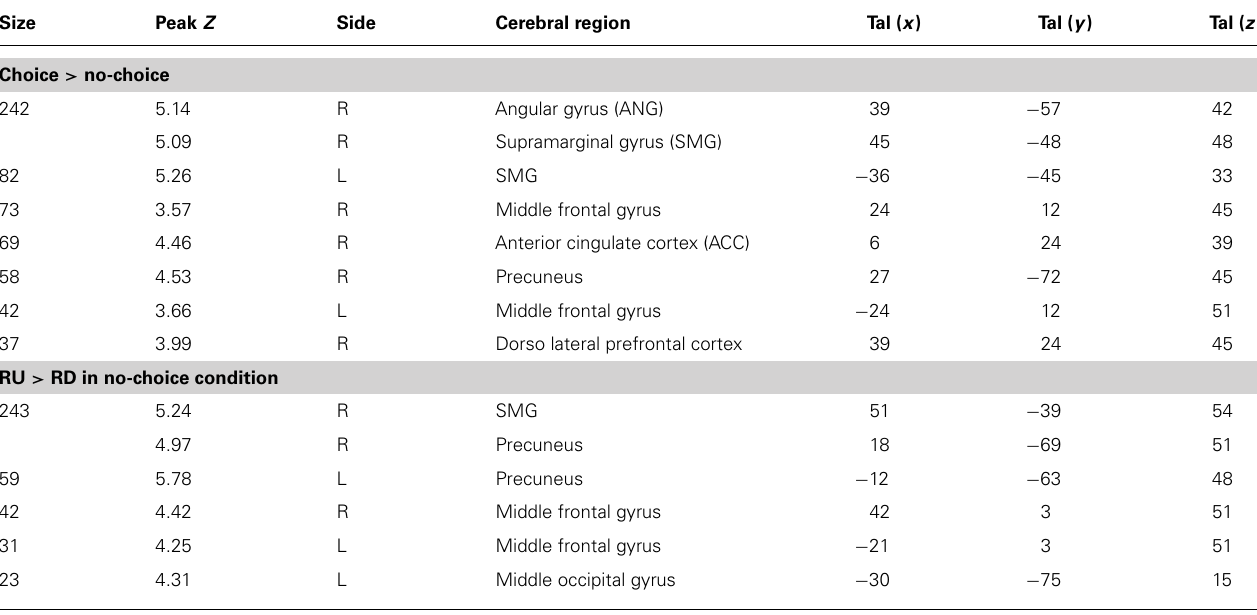
Table 3 | Brain activations associated with strategy selection and strategy execution. Size Peak Z Side Cerebral region Choice >